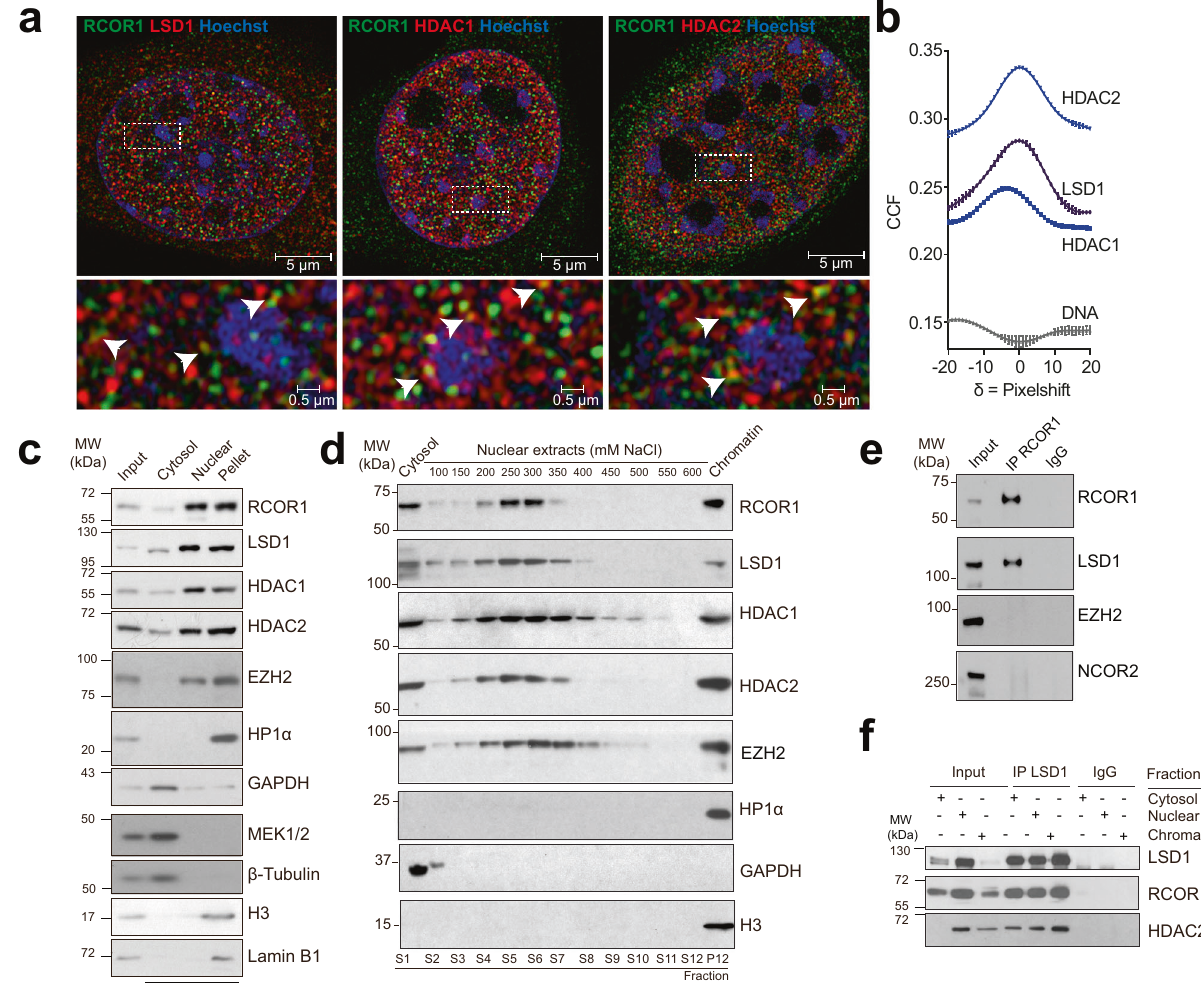
Fig. 1 Three different subpopulations of the LSD1-RCOR1-HDAC1/2 complex coexist in cells. a HT22 cells were stained with double immunolabeling of RCOR1 (green) and LSD1, HDAC1, or HDAC2 as shown in red. Bottom panels show magni fi ed regions of original images highlighted inside dashed rectangles. White arrows indicate regions where RCOR1 and its binding partners are colocalizing. Images are representative of three independent experiments. b Van Steensel ’ s plot of 2D colocalization between RCOR1 and each co-stained protein or DNA. CCF: Cross correlation function. c Western blot analysis of subcellular fractionation in HT22 cells. GAPDH, MEK1/2, and β -Tubulin were assayed as cytosolic markers, while H3 and Lamin B1 as chromatin and nuclear lamina markers, respectively. S: Supernatant. P: Pellet. MW: Molecular weight. kDa: Kilodalton. Panels are representative of three independent experiments. d Western blot analysis of sequential salt extractions of nuclear contents in HT22 cells. GAPDH and H3 were assayed as cytosolic and chromatin markers, respectively. Images are representative of two independent experiments. e Western blot analysis of the immunoprecipitation of RCOR1. LSD1 was assayed as a positive control of co- immunoprecipitation. IP: Immunoprecipitation. IgG: Immunoglobulin. This experiment was performed once. f Western blot analysis of the immunoprecipitation of LSD1 in cytosolic, nuclear soluble, and chromatin fractions. IP: Immunoprecipitation. IgG: Immunoglobulin. Panels are representative of two independent experiments. Source data are provided as a Source Data fi